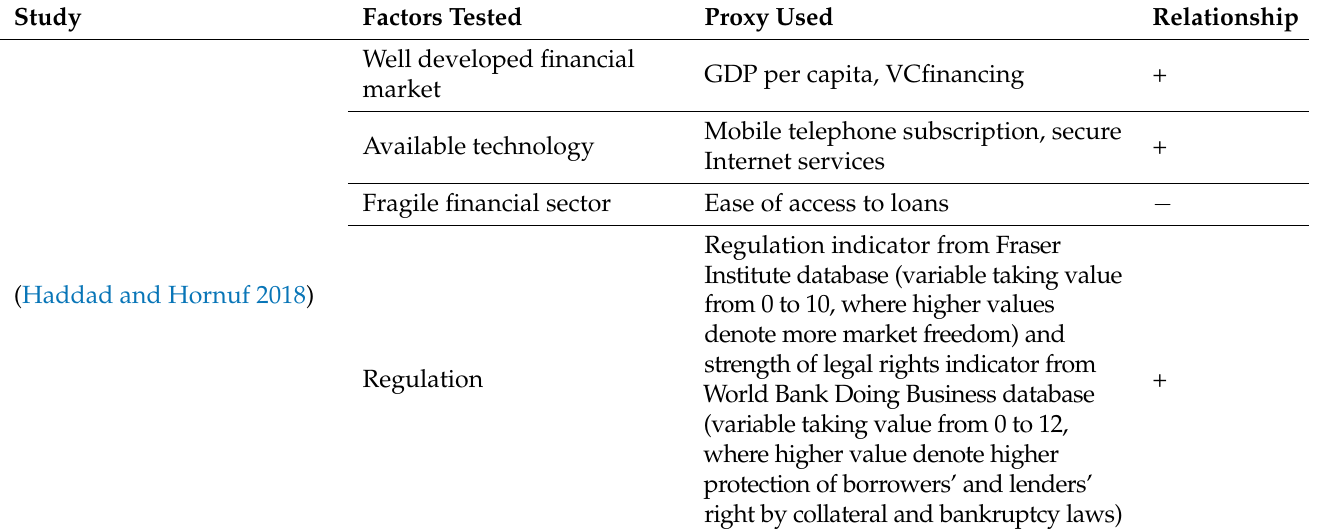
Table 1. Review of the factors that support FinTech